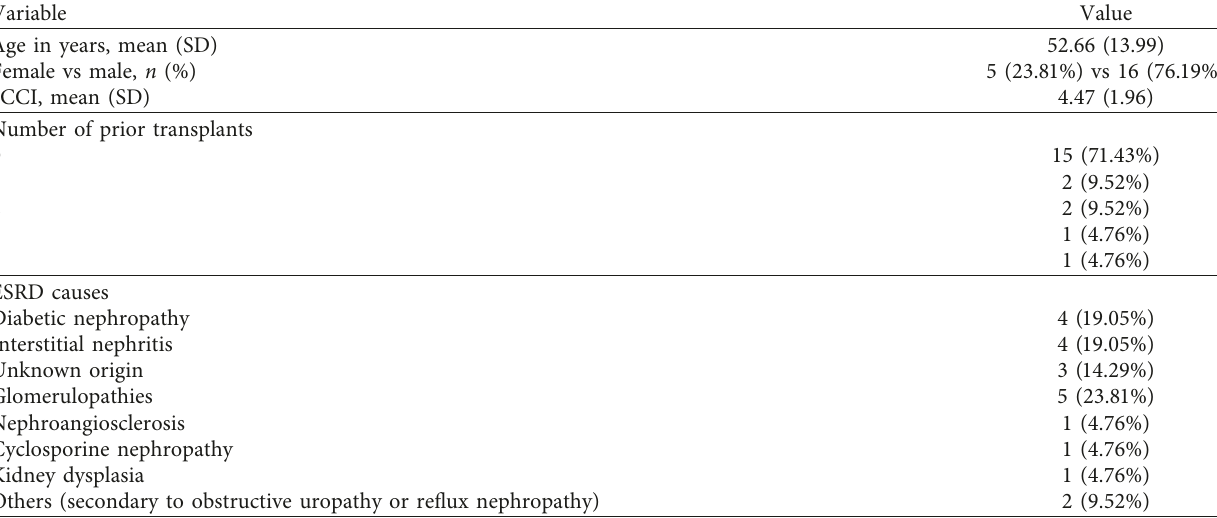
Table 2: Baseline characteristics.